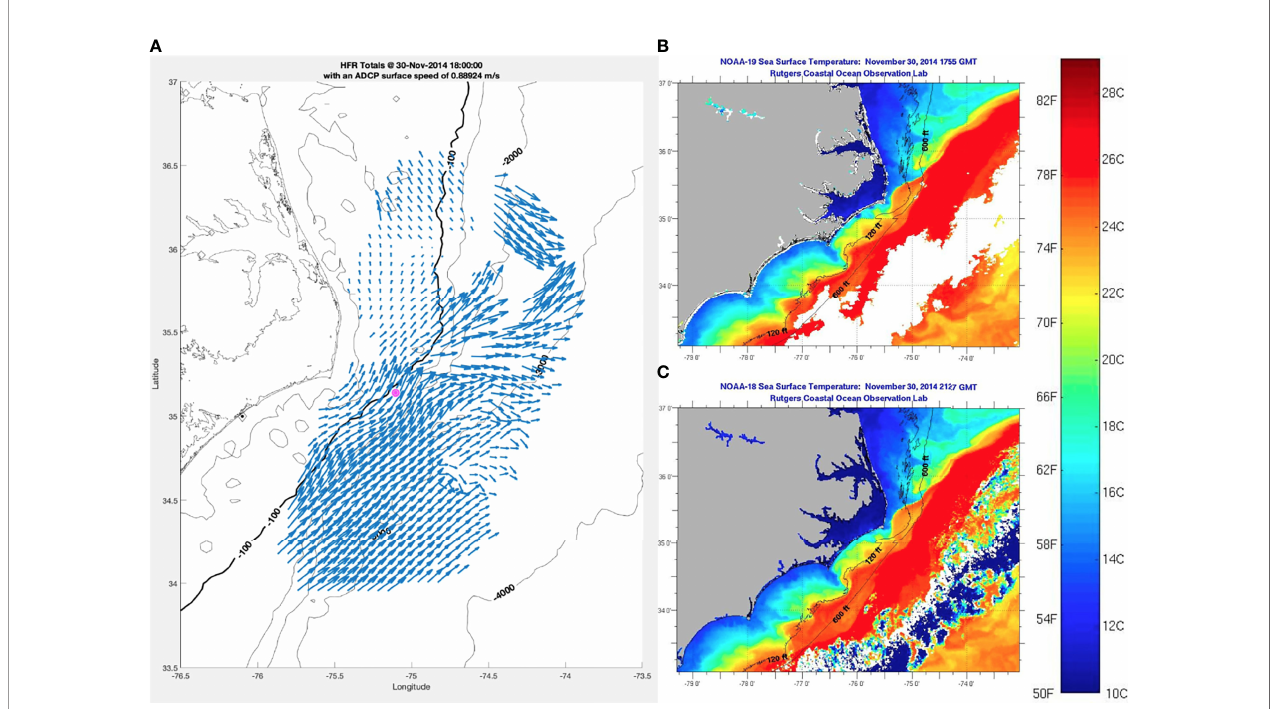
FIGURE 11 | (A) : HFR surface currents on November 30 at 18:00 GMT, with ADCP location at pink dot. (B) SST image on November 30th at 17:55 GMT. (C) SST image on November 30th at 21:27